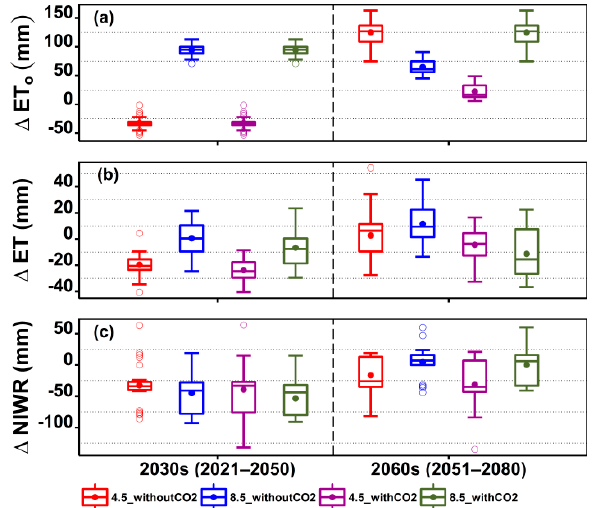
Figure 8. Projected changes in wheat-seasonal cumulative (a) reference crop evapotranspiration (ET o ), (b) actual crop evapotranspiration (ET) and (c) net irrigation water requirements (NIWR) during the future time slices. The boxes in Figure 8a–c represent the inter-quartile range (IQR), the whiskers extend up to 1.5 times the IQR, the dots and horizontal lines inside the boxes represent mean and median, respectively, and outliers are shown as hollow dots outside the boxes. Each box shows the difference of baseline average values with the mean value of nine GCMs.